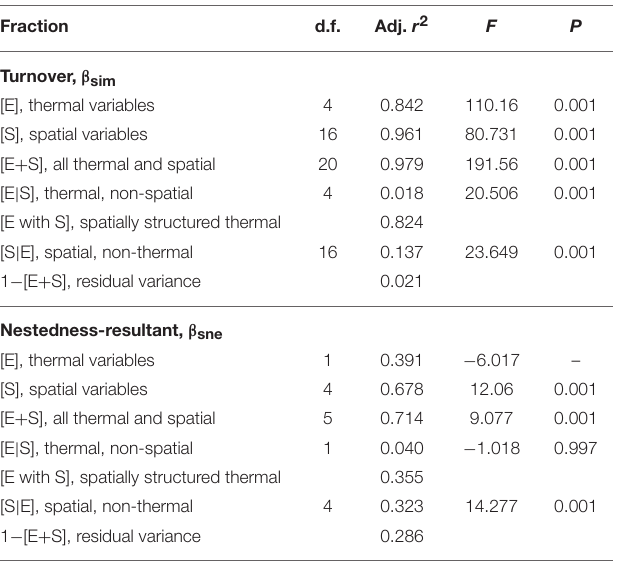
TABLE 1 | Variance partitioning of β sim and β sne by the thermal and spatial predictors.